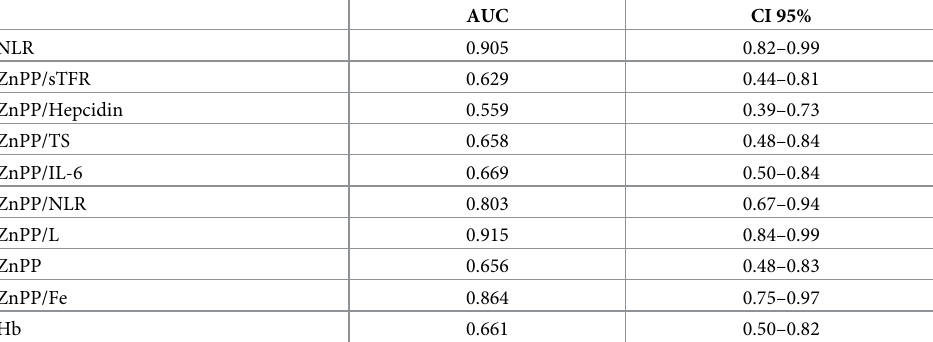
Table 5. Receiver operating characteristic (ROC) curve analysis for ZnPP and ZnPP-to-different markers along with NLR and Hb.